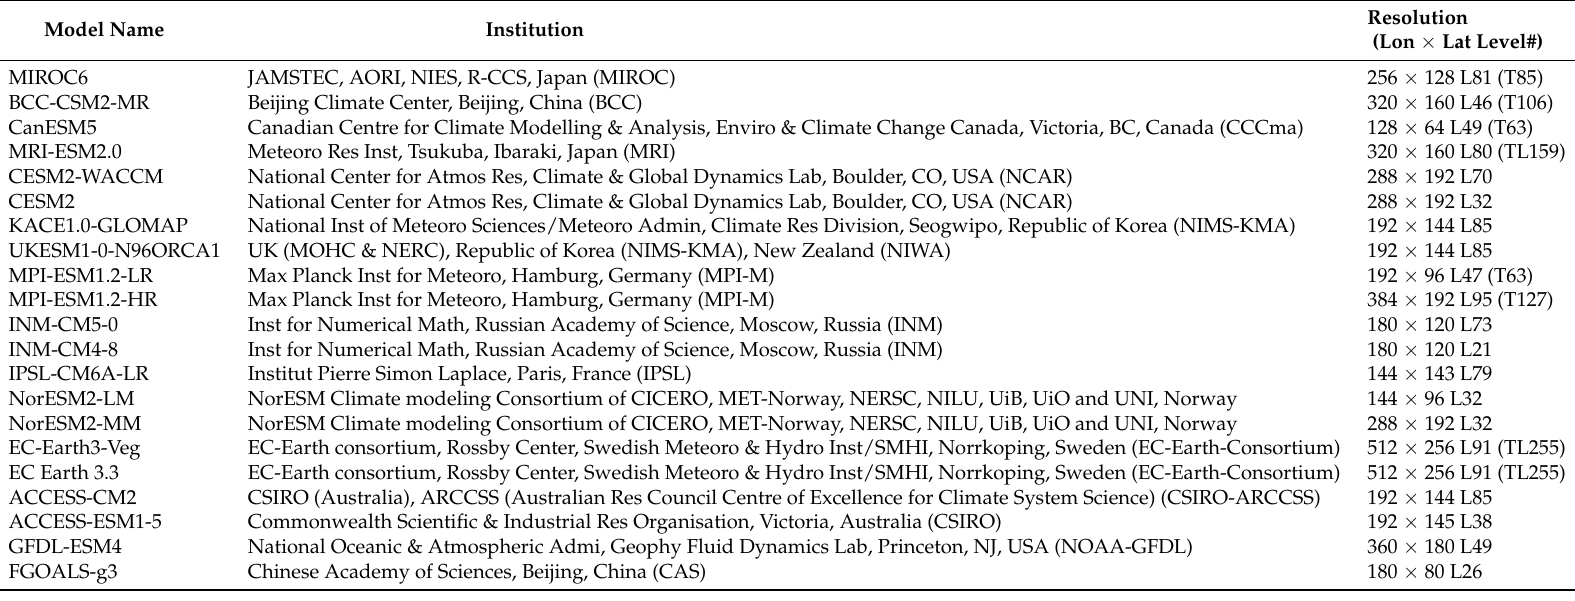
Table 1. The list of 21 CMIP6 (Coupled Model Intercomparison Project Phase 6) models analyzed in this